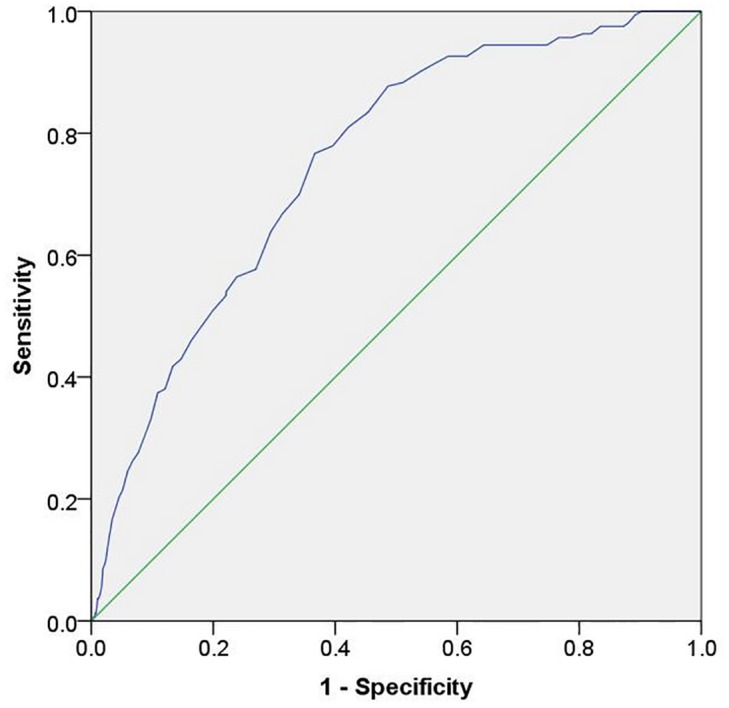
Receiver operating characteristic curve of SUDOSCAN-DKD score in detecting chronic kidney disease in Chinese patients with type 2 diabetes